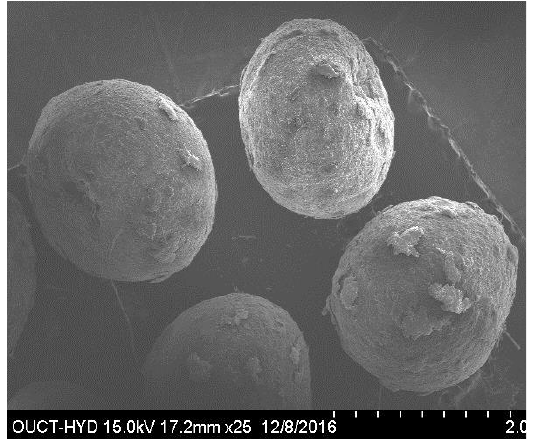
Figure. 4 SEM images of optimized formulation Table 3. Average diameter, drug entrapment efficiency and % yield of acyclovir Microspheres